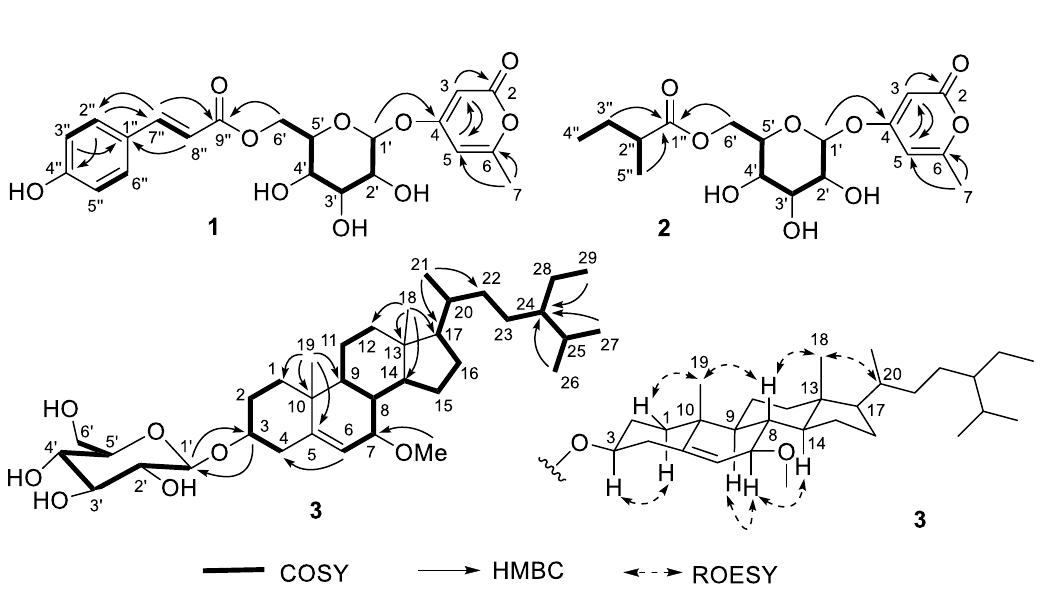
Fig. 2 Key 2D NMR correlations of compounds 1 –